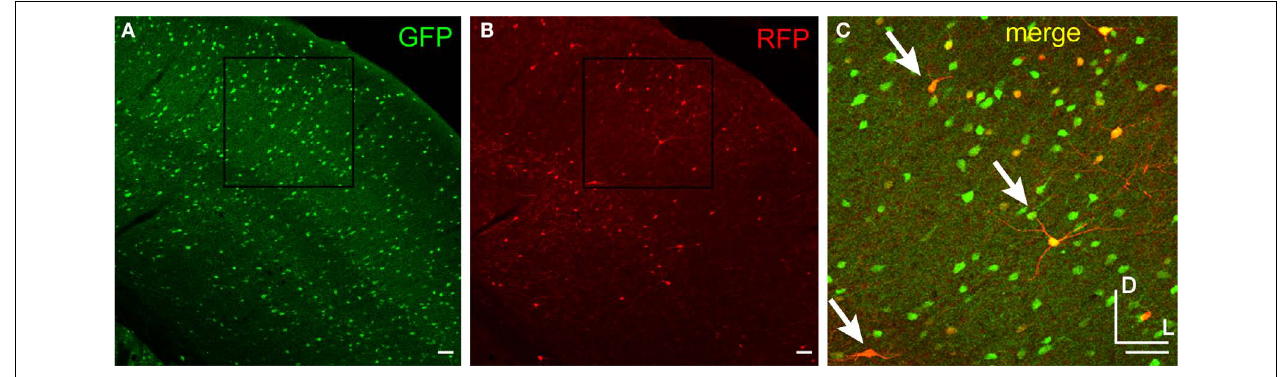
FIGURE 6 | AAV-fSST predominately labeled inhibitory neurons in mouse cortex. Mouse cortex with inhibitory neurons expressing GFP under the control of the GAD67 promoter (A) was injected with AAV-fSST expressing RFP (B) . Panel (C) is the overlap of the boxed region in